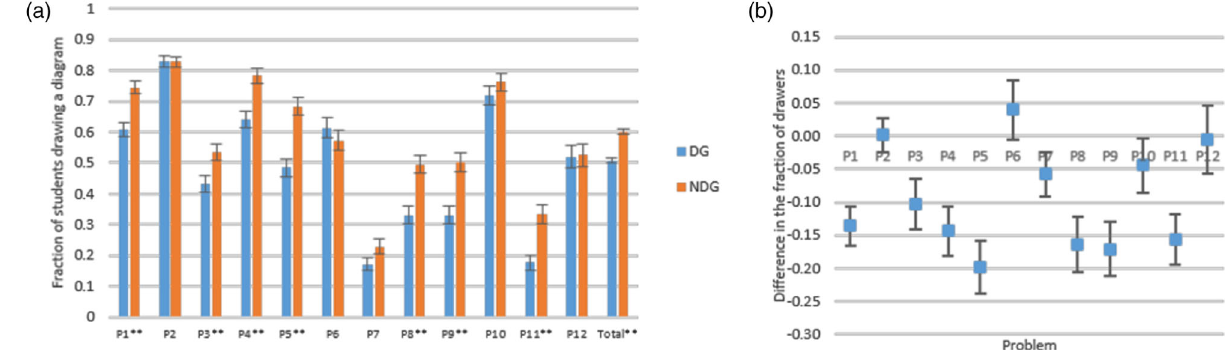
FIG. 4. Comparing the drawing behavior between the two conditions. (a) Percentage of students who chose to draw a diagram during problem solving. The rightmost columns are the drawing percentage aggregated over all 12 problems. *Difference is significant at the 0.05 level. ** Difference is significant at the 0.01 level. (chi-squared test) (b) The difference in percentage between the two conditions on each